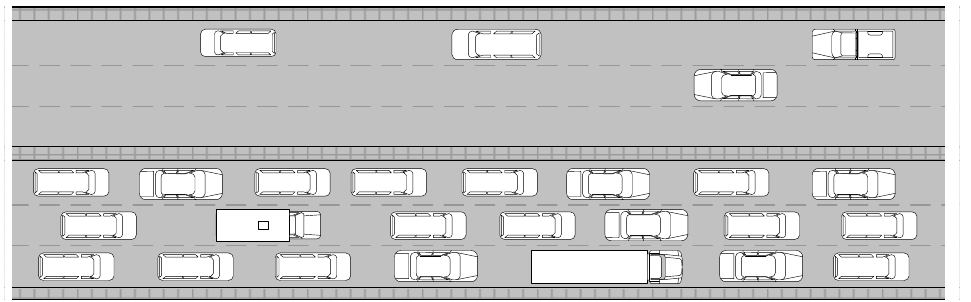
Figure 2. Highway scenario with a traffic jam in one direction of driving and free flow conditions in the other direction. Vehicles under the same channel load conditions can have different application requirements.